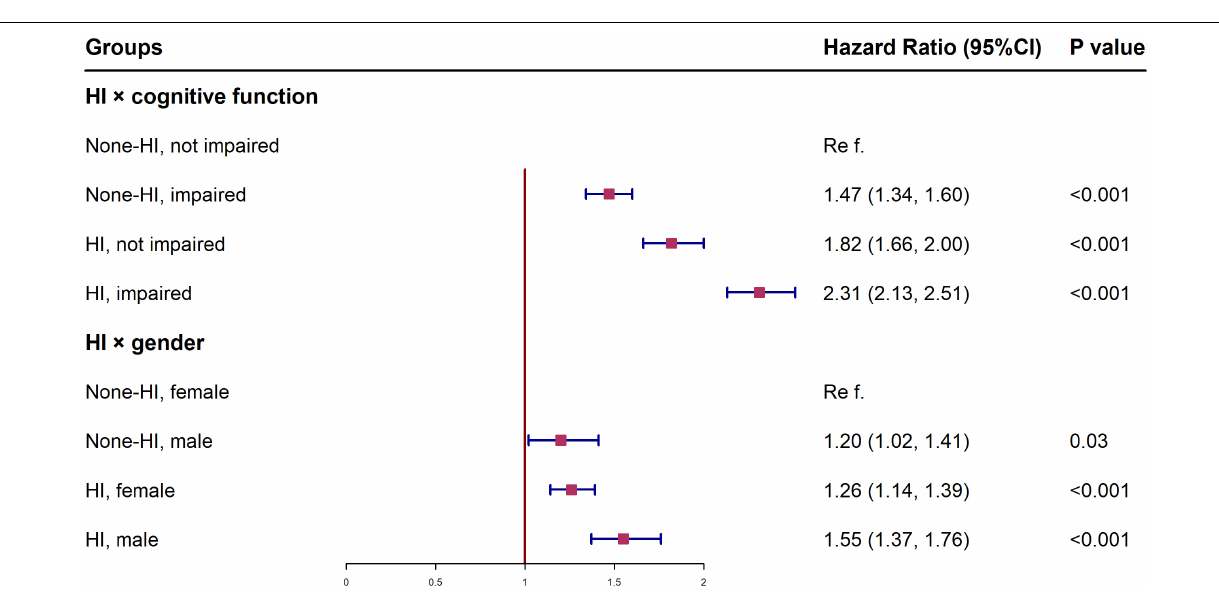
FIGURE 3 | Interactions between hearing status and cognitive function, gender in the association with all-cause mortality among Chinese aged ≥ 65 years. † All models were adjusted for gender, age, education, residence, and marital status, smoking status, drinking status, regular leisure activities, ADL, hypertension and diabetes. HI, hearing impairment; CI, confidence interval; ADL, activities of daily